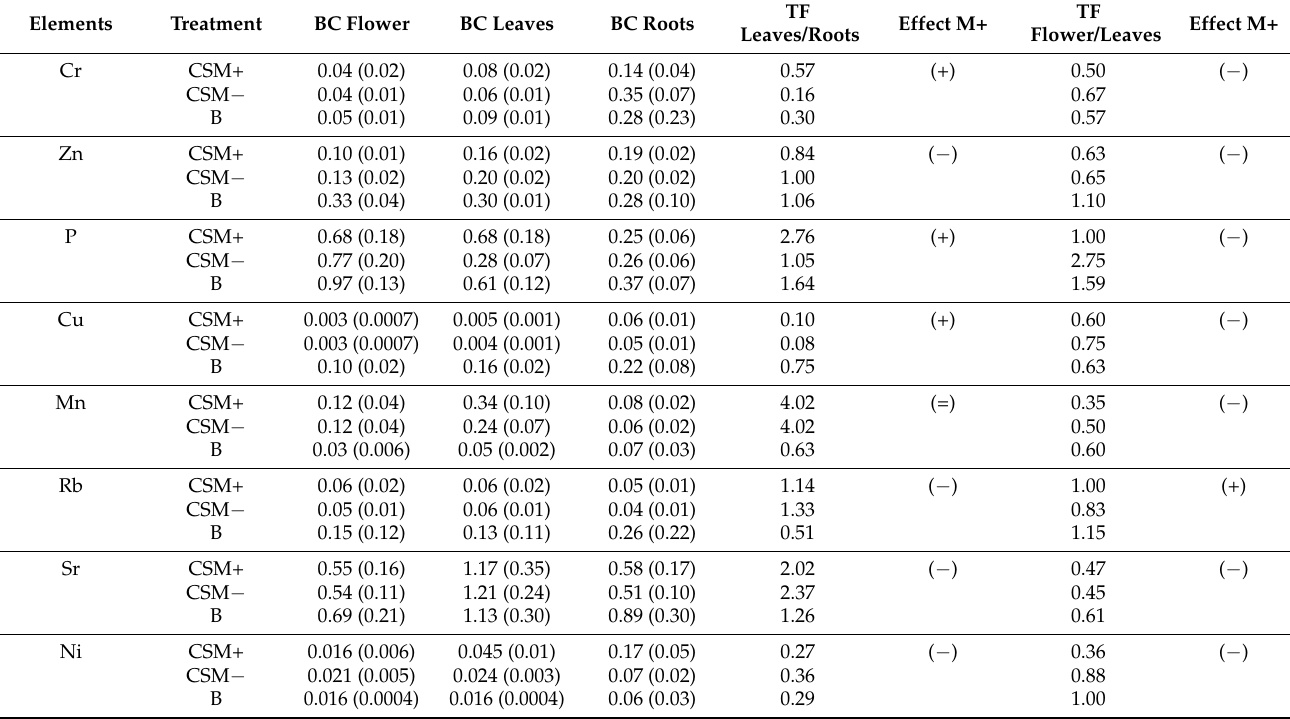
Table 3. Values of the bioaccumulation coefficients (BC) and translocation factors (TF) from roots to leaves and from leaves to flowers of the chemical elements under study in Helianthus annuus plants growing in blank soil (B) or contaminated soil substrate (CS), inoculated (CSM+) and uninoculated (CSM-) with the arbuscular mycorrhizal fungus Rhizophagus intraradices GA5 strain. The comparative effects of TF in mycorrhization and control treatment are shown as greater (+), less ( − ), or equal